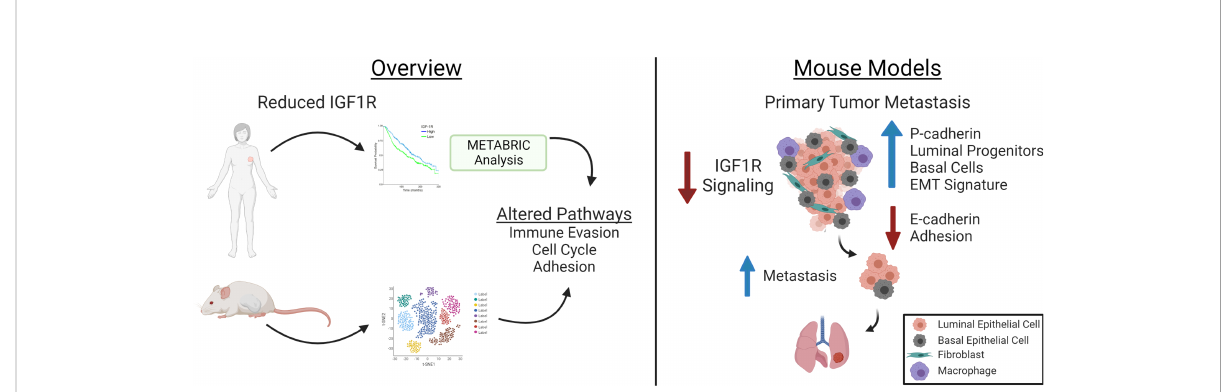
FIGURE 9 Model for how Reduced IGF1R in Human Breast Tumors (left) and in Mouse Basal-Like Mammary Tumors results in Enhanced Metastasis. The overview panel (left) summarizes human breast cancer data showing inverse correlation between IGF1R expression and patient survival and lymph node positivity [see (9, 17)] and from METABRIC data analyses in the current manuscript showing low tumor IGF1R expression is correlated with gene expression indicating increased tumor cell invasion properties and cell cycle and decreased cell adhesion. Similar pathways were identi fi ed from scRNA-Seq of the tumors in the mouse models with reduced IGF1R signaling or expression. Analyses of the mouse models (right) revealed decreased IGF1R signaling in primary tumor epithelium resulted in increased lung metastases and alterations associated with metastasis including increased P-cadherin in E-cadherin-positive cells, increased EMT signatures in luminal and basal cell populations and in decreased E-cadherin and cell adhesion. Created with